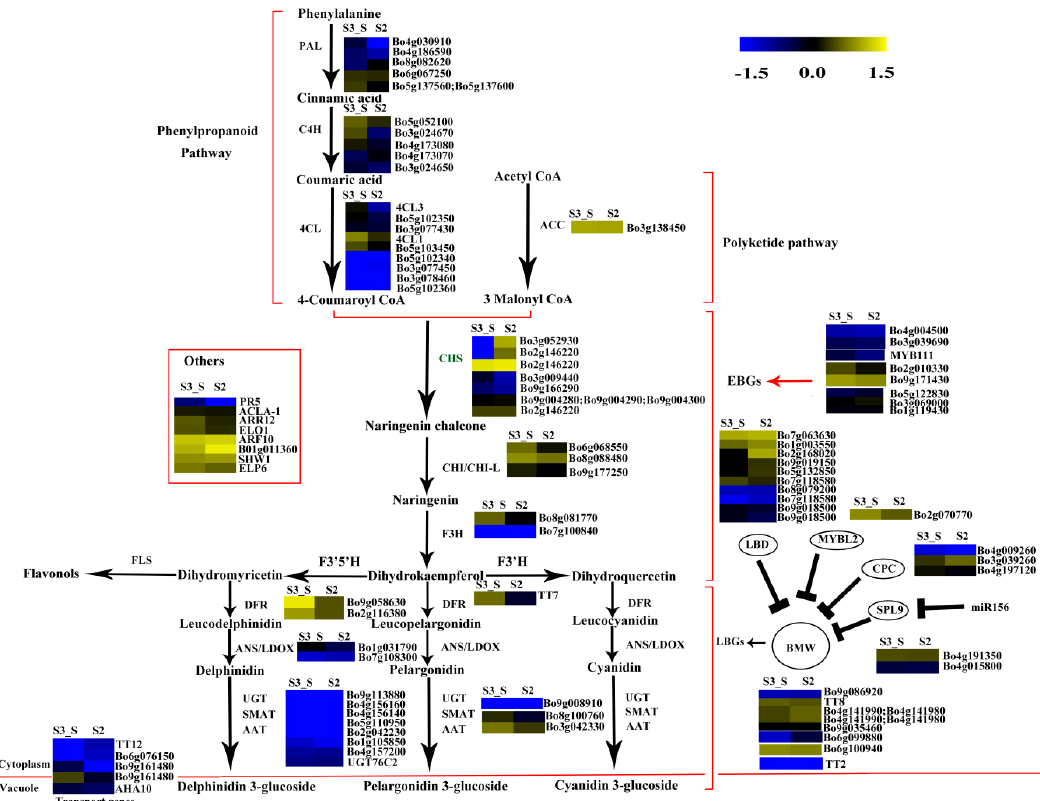
Figure 10. Expression pattern of the genes involved in anthocyanin biosynthesis in S3_S vs. S2. Enzyme names in green represent downregulated genes in S3_S vs. S2. The red parentheses represent the four pathways, the black and red arrows represent the positive regulation and black “ T ” represent negative regulation. The genes in the red box are the other genes involved in anthocyanin biosynthesis.